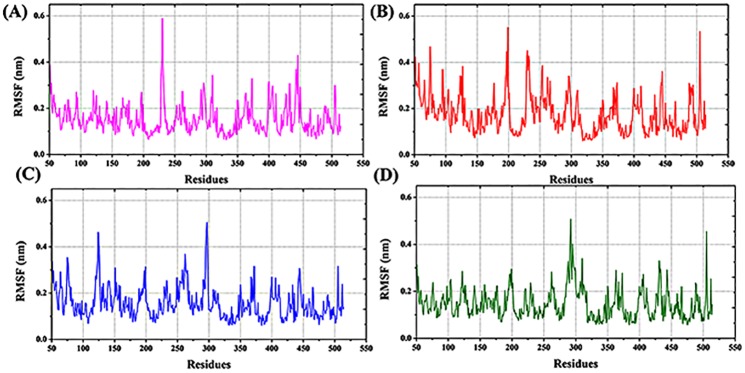
The root mean square fluctuation of CYP24A1 models CYP24A1apo (gray), CYP24A1ketoconazole (red), CYP24A1CTA-091 (blue), CYP24A1CTA-018(green).